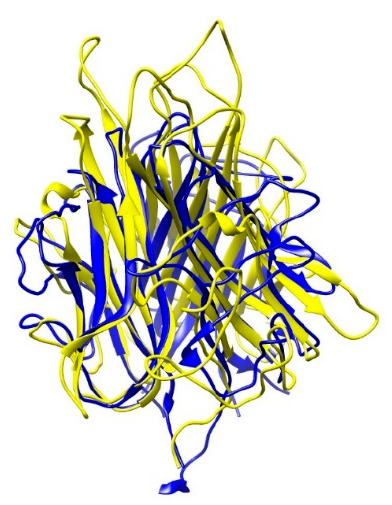
Figure 5. Superposition of trimeric globular domain of adiponectin (PDB: 6U66) in blue and TNF- α (PDB:1TNF) in yellow shows high 3D-structure similarity.